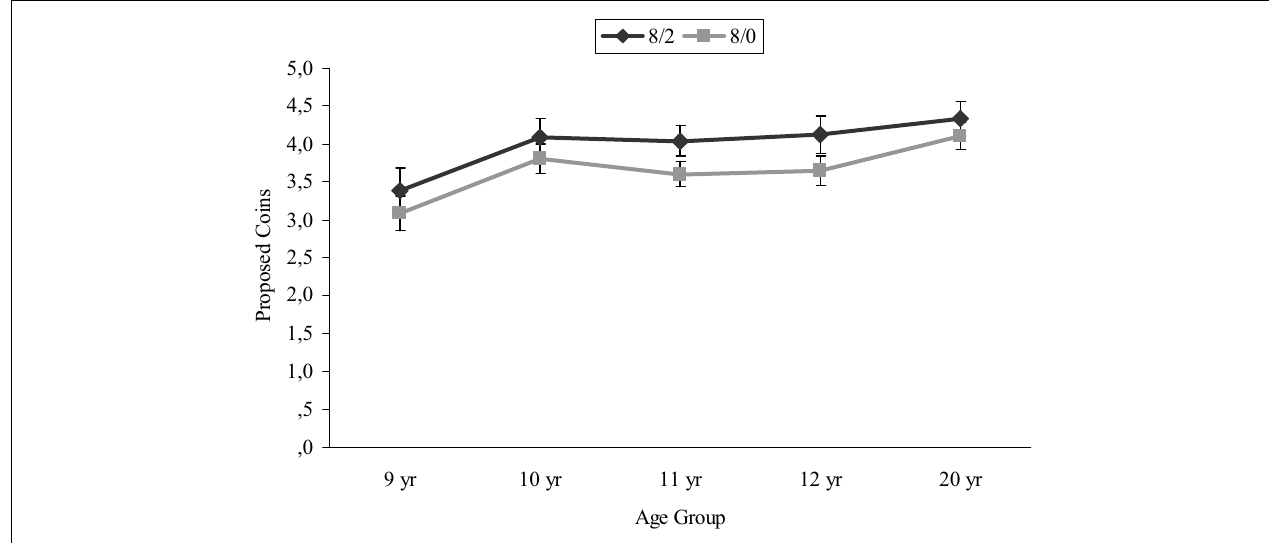
FIGURE 3 | Mean amount of proposed coins and standard errors in the complete 8/0 condition versus the hidden 8/2 condition in all age groups.